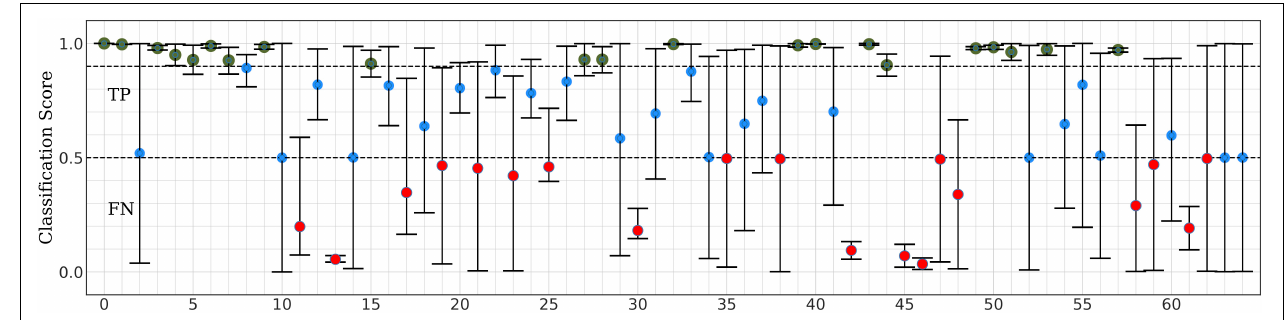
FIGURE 4 | Classification scores of ConcNet 2 for a pair of one control and one concussed participant based on a total of sixteen data segments.